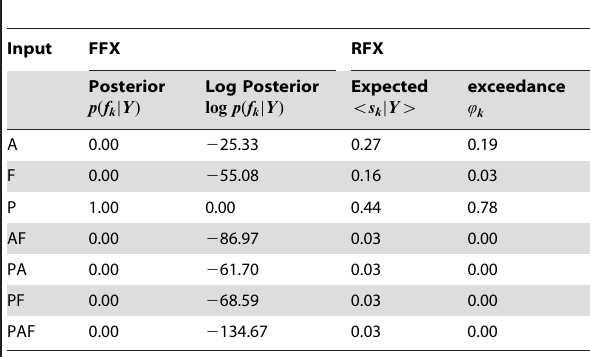
Table 1. Inference over input families.